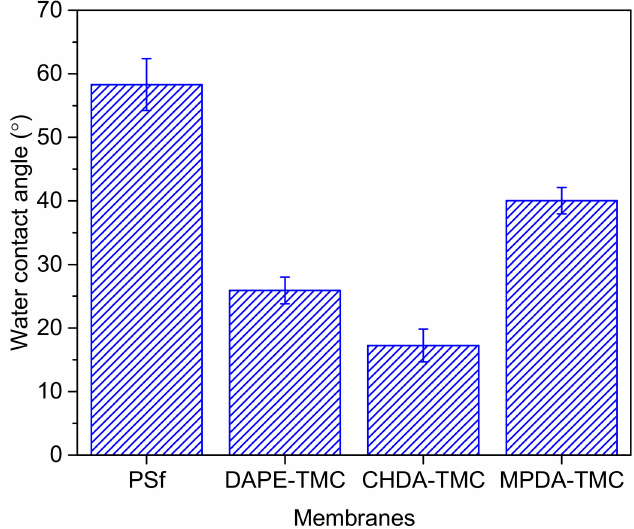
Figure 7. Hydrophilicity of PSf support and TFC